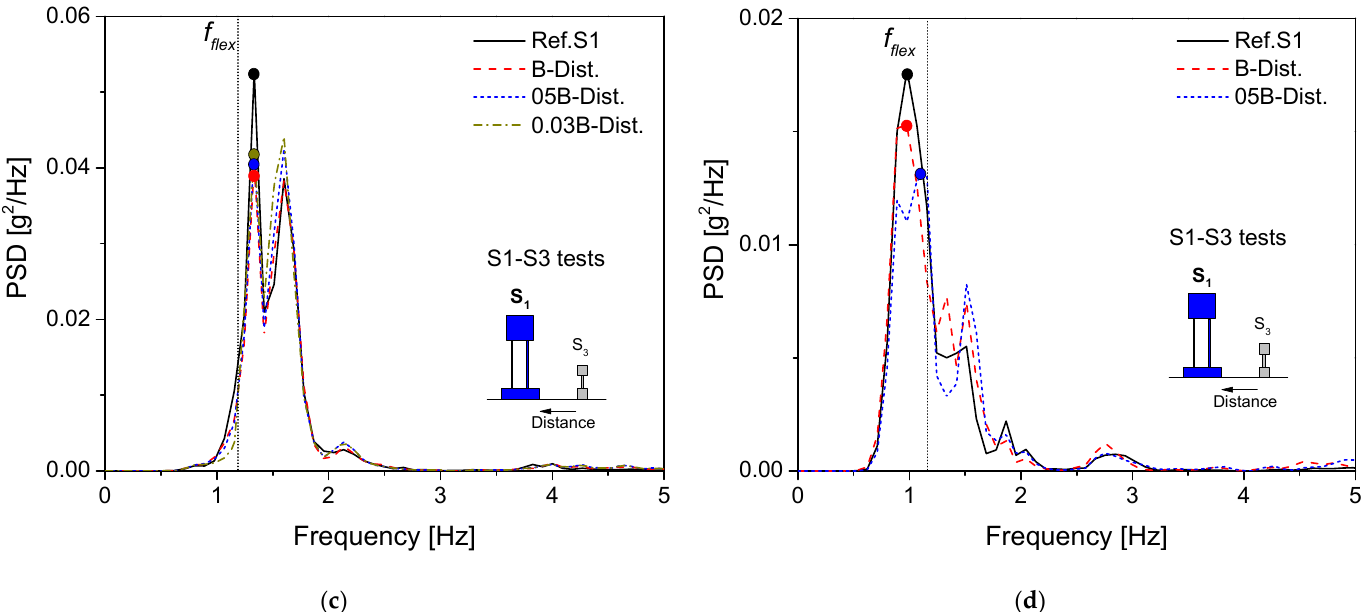
Figure 7. Power Spectra Density (PSD) of S1 structure ( a ) S1‐S2 tests with artificial EQ; ( b ) S1‐S2 tests with Hachinohe EQ; ( c ) S1‐S3 tests with artificial EQ; ( d ) S1‐S3 tests with Hachinohe EQ at M_Input intensity. Solid circles indicate peak PSD at resonant frequency. f flex indicates flexible‐base frequency of S1 structure.